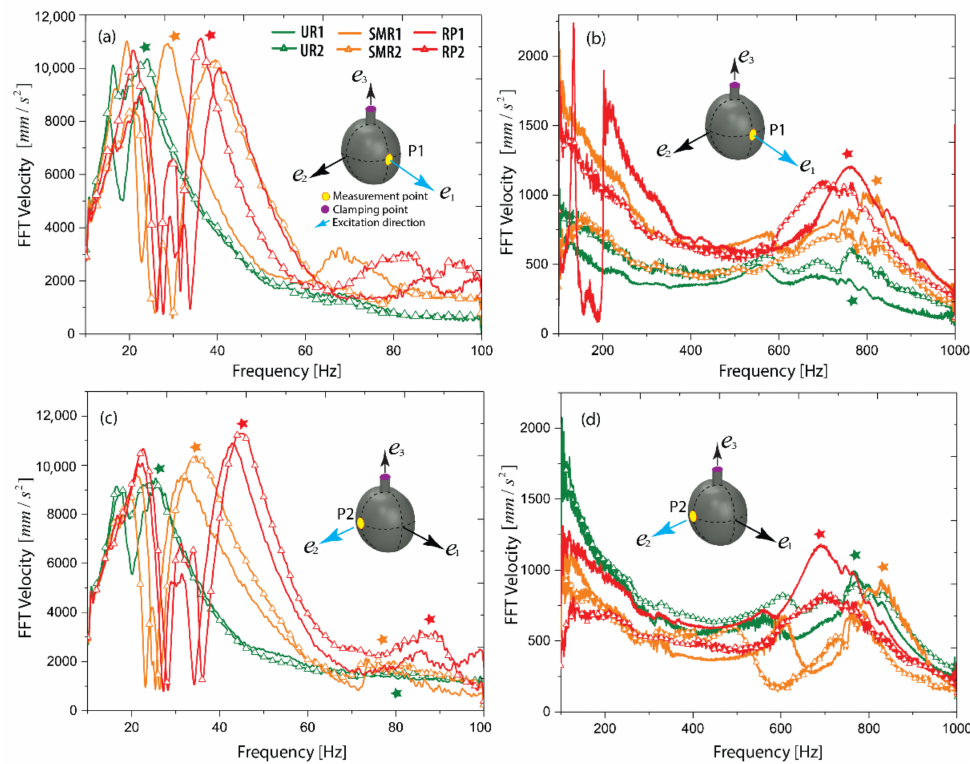
Figure 8. Fast Fourier transform (FFT) of the velocity measurements. At the e 1 direction: ( a ) 10–100 Hz and ( b ) 100–1000 Hz. At the e 2 direction: ( c ) 10–100 Hz and ( d ) 10–1000